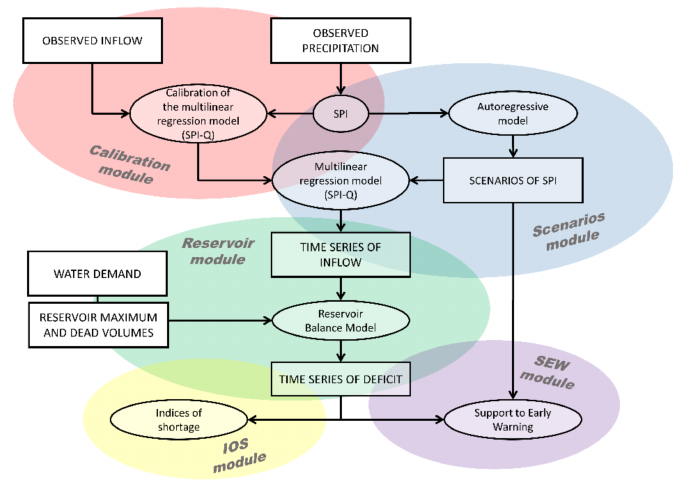
Figure 1. Methodology flowchart. Colored ellipses refer to the steps of analysis of the tool INOPIA, described in details in Sections